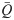
Effect of time delay between contractions of adjacent lymphangions in branching networks with nv = 4 when Δtg = Δtv.(A) Pump function curves as Δtv increased from 0 to 3.5 by steps of 1.0 s (Increasing pb). (B) Q¯vs. Δtv: effect of pressure difference across the network. Flow rate response as Δtv incrementally increased from 0 to 3.5 s. For reverse travelling waves (dashed line) equivalent time delay in the reverse direction is presented as 3.5 –(Δtg = Δtv).